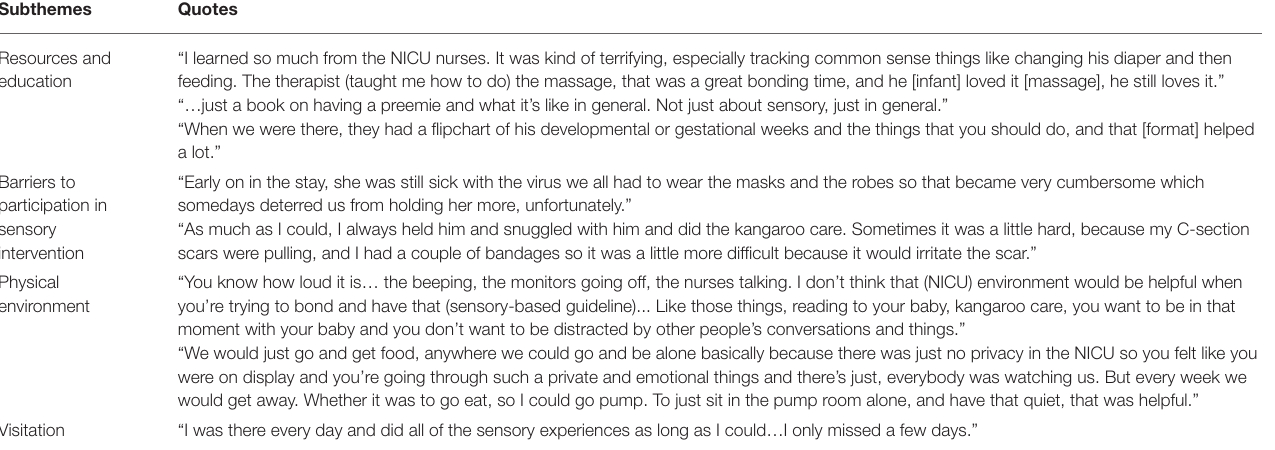
TABLE 5 | Theme 3: Maternal Participation in Sensory Interventions in the NICU. Subthemes